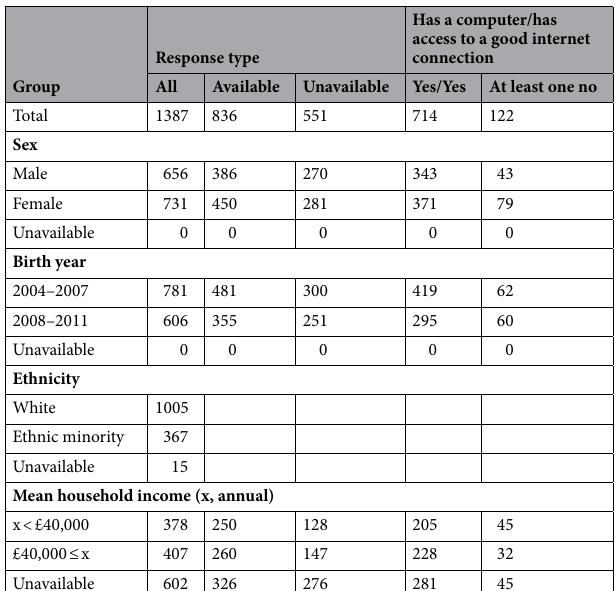
Table 1. Digital inclusion characteristics according to key sociodemographic variables (ethnicity data suppressed due to low numbers to protect the identities of